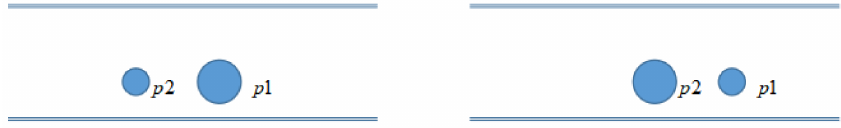
Figure 8. A schematic diagram of the migration of a pair of particles of different sizes.